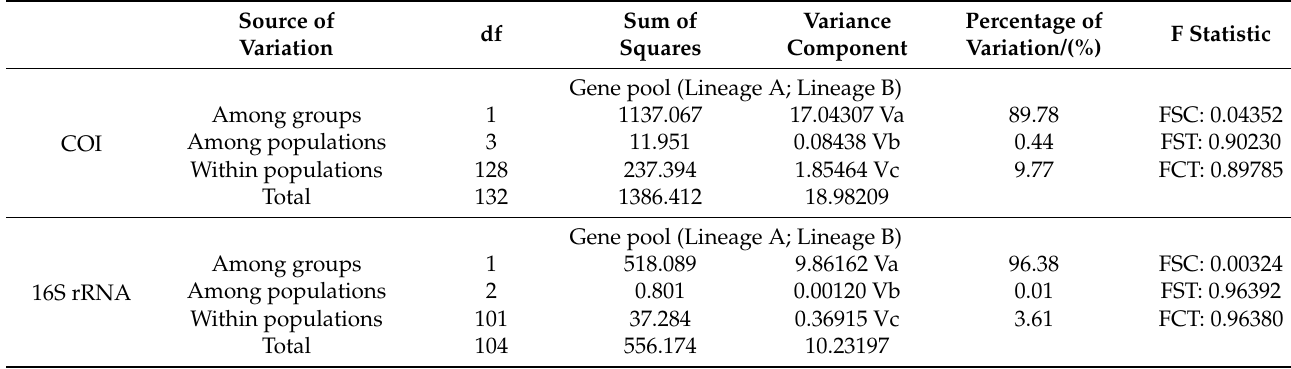
Table 2. AMOVA analysis of L. ( N. ) beka localities, based on COI and 16S.